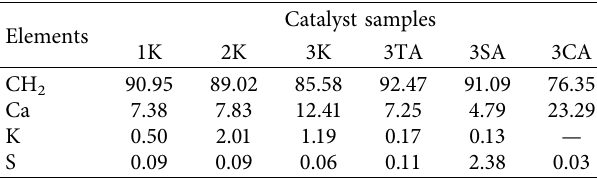
Figure 4: X -ray diffraction patterns of alkaline and acidic het- erogeneous catalysts used in the transesterification of vegetable oil with methanol to obtain biodiesel. Table 2: Elemental composition obtained from the XRF analysis of alkaline and acidic catalyst samples.